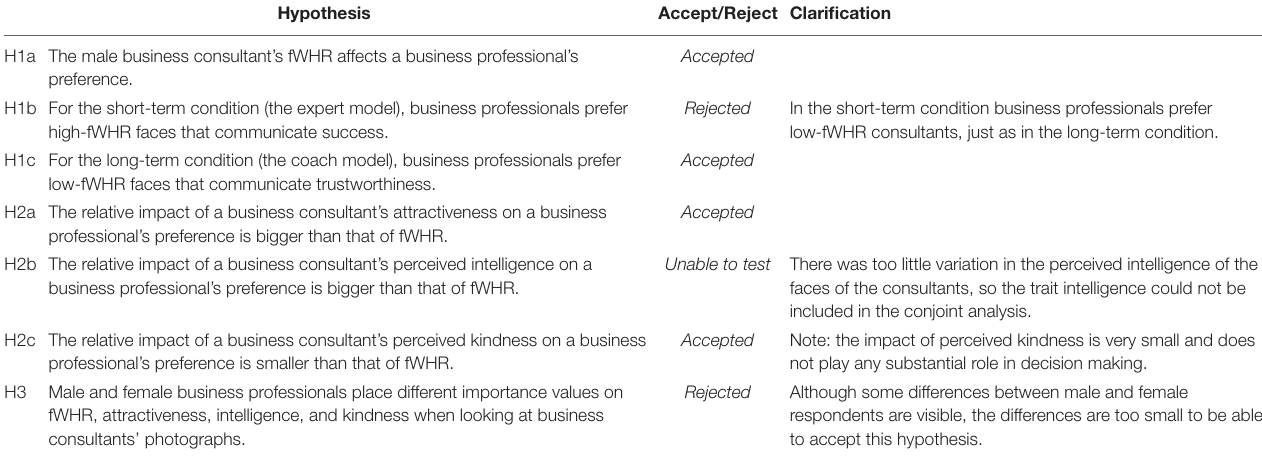
TABLE 6 | Overview of the tested